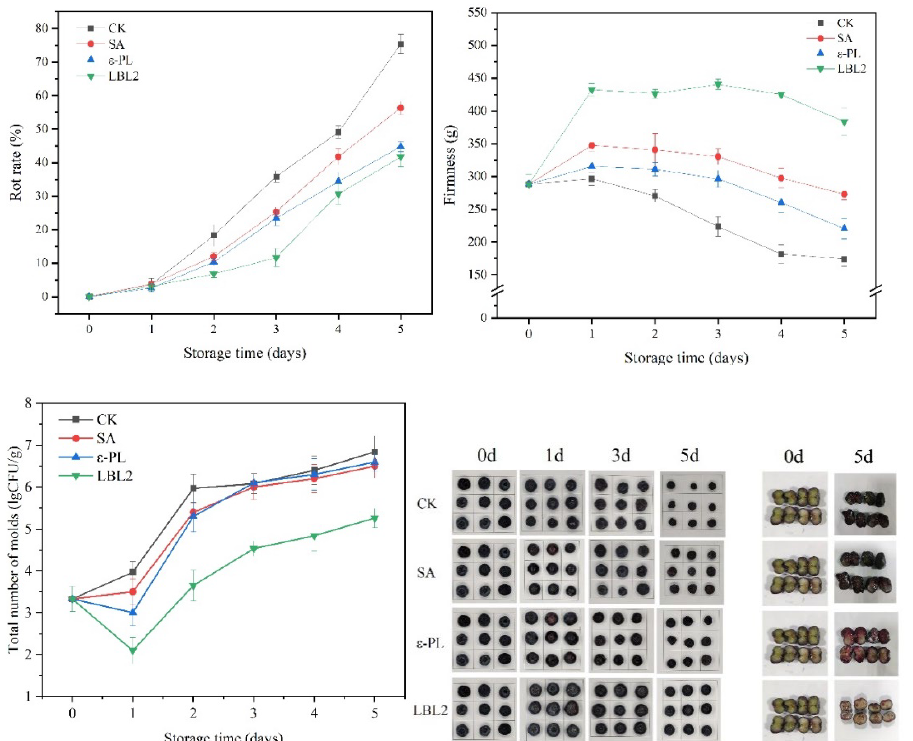
Figure 13. The change in rot rate (%), firmness, total number of molds (log CFU/g), and appearance of the blueberry during storage. CK indicates the control; SA indicates 1.5% Sodium alginate coating; ε -PL indicates 4% ε -polylysine coating; LBL2 indicates layer-by-layer coating. Vertical bars indicate standard deviations.